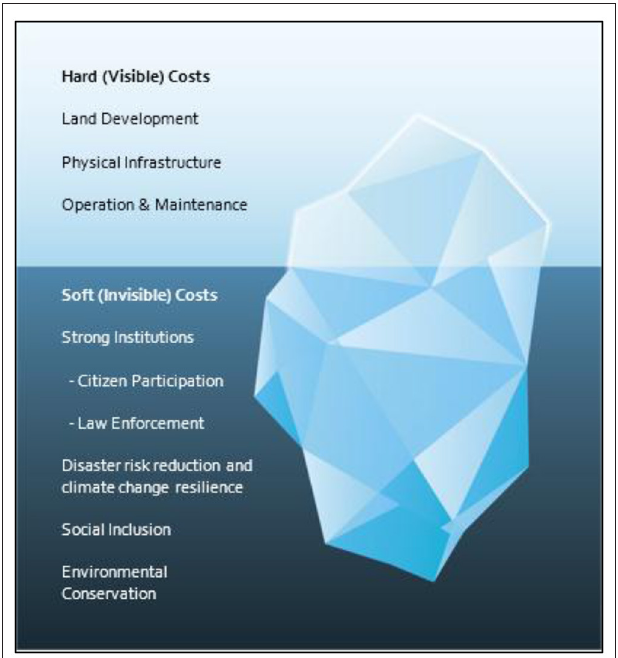
FIGURE 1 | Illustration representing visible and invisible costs of sustainable urban development. Source: ( Prakash et al., 2020).